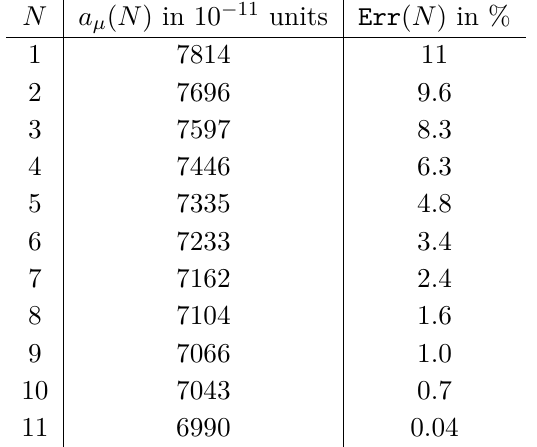
Table 1 . Predicted values of the model anomaly from the approximants defined in eq. (5.9) and the errors in % defined by eq. (5.10) in the third